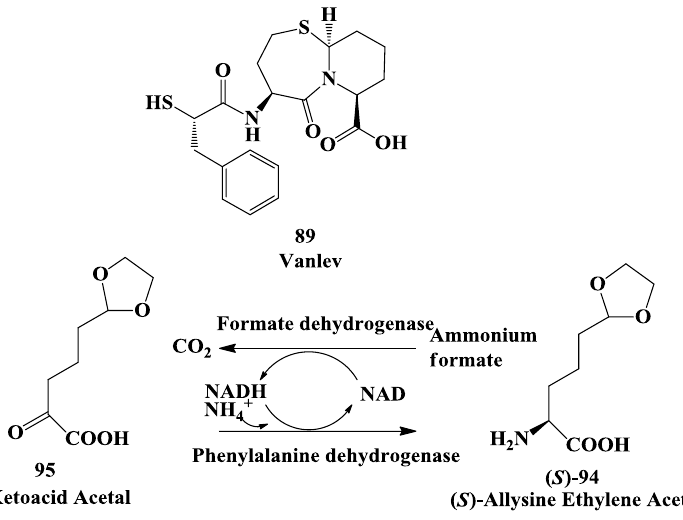
Figure 25. Vanlev: Enzymatic synthesis of allysine ethylene